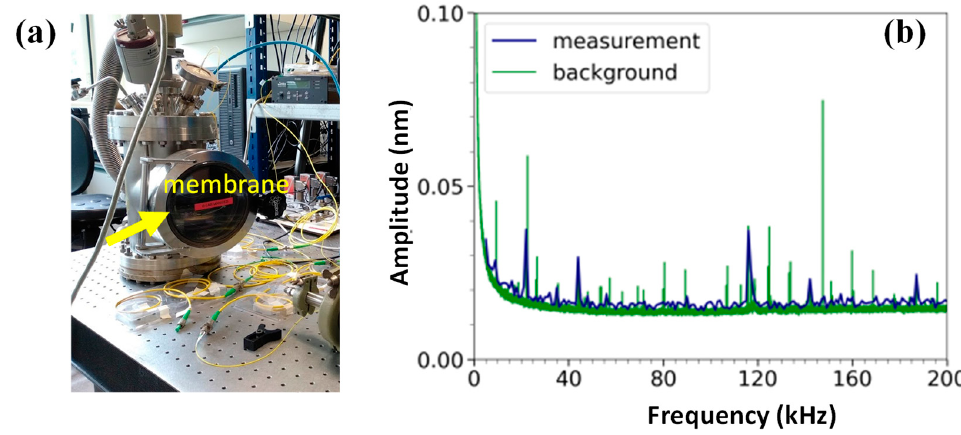
Figure 7. ( a ) The measurement setup used in methane detection experiments. ( b ) The frequency re- sponse of the membrane, which was inside the big chamber. The background is shown as a com- parison.